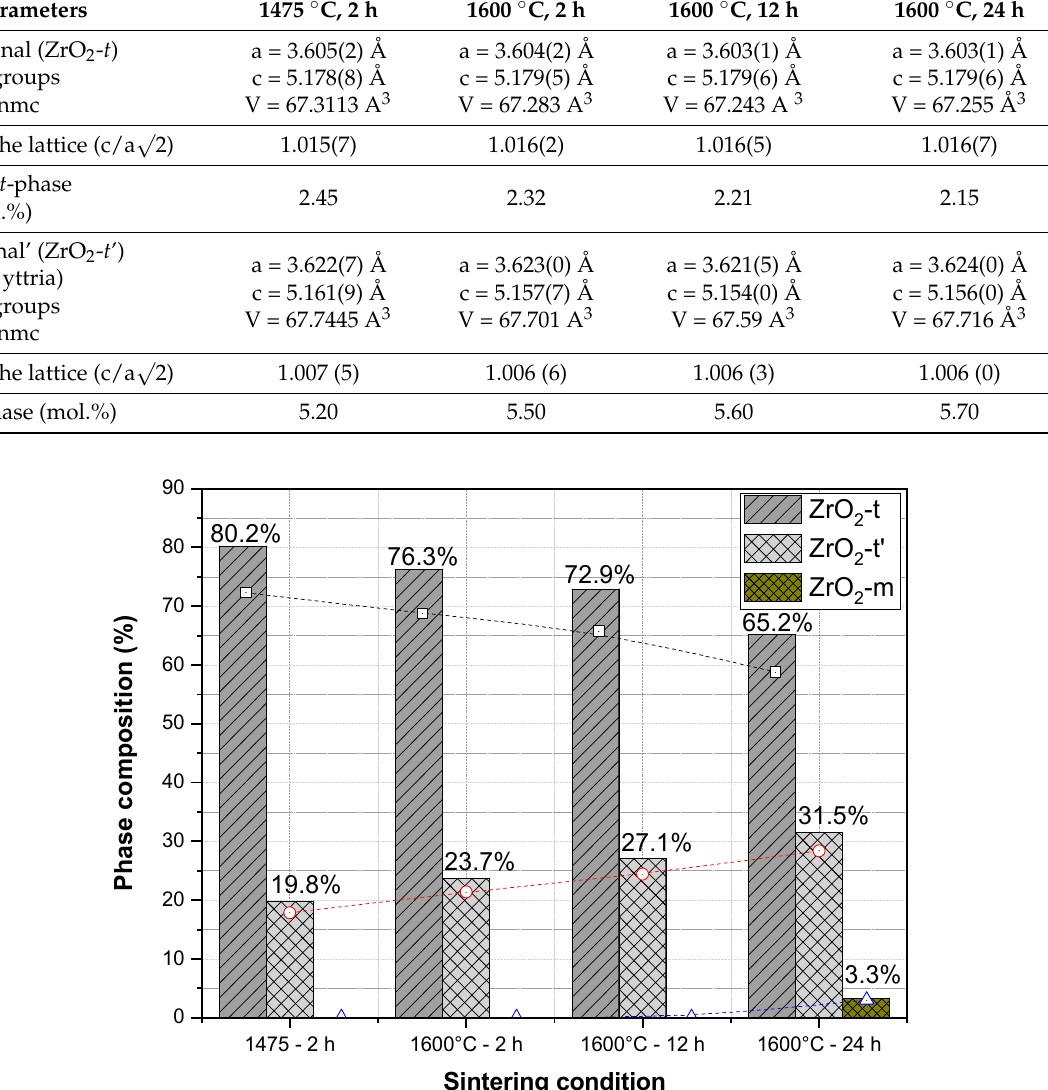
Figure 4. XRD crystallographic composition of the Y-TZP samples sintered under different conditions.